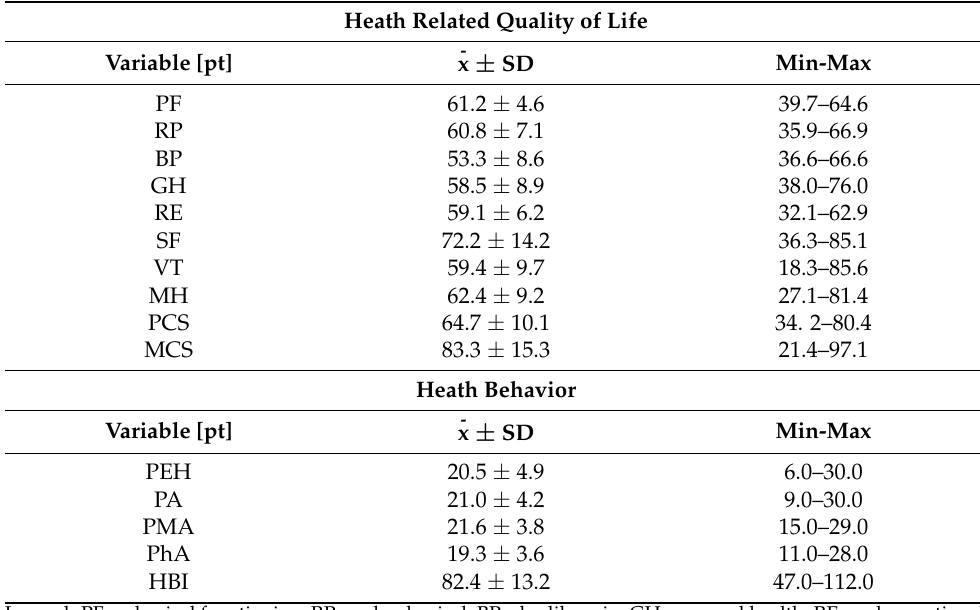
Table 1. Health-related quality of life and the intensity of health behaviors in female medical staff. Heath Related Quality of